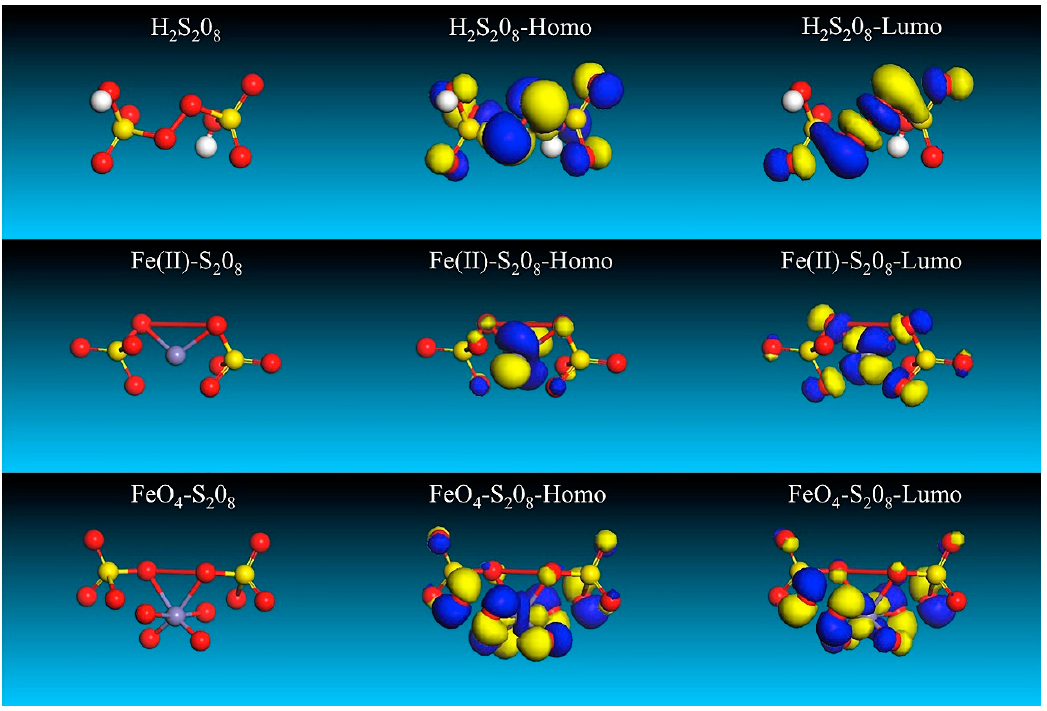
Figure 7. HOMO and LUMO orbital analysis of possible intermediates in homogeneous and heterogeneous process. Table 1. Orbital energy analysis of homogeneous and heterogeneous intermediates.